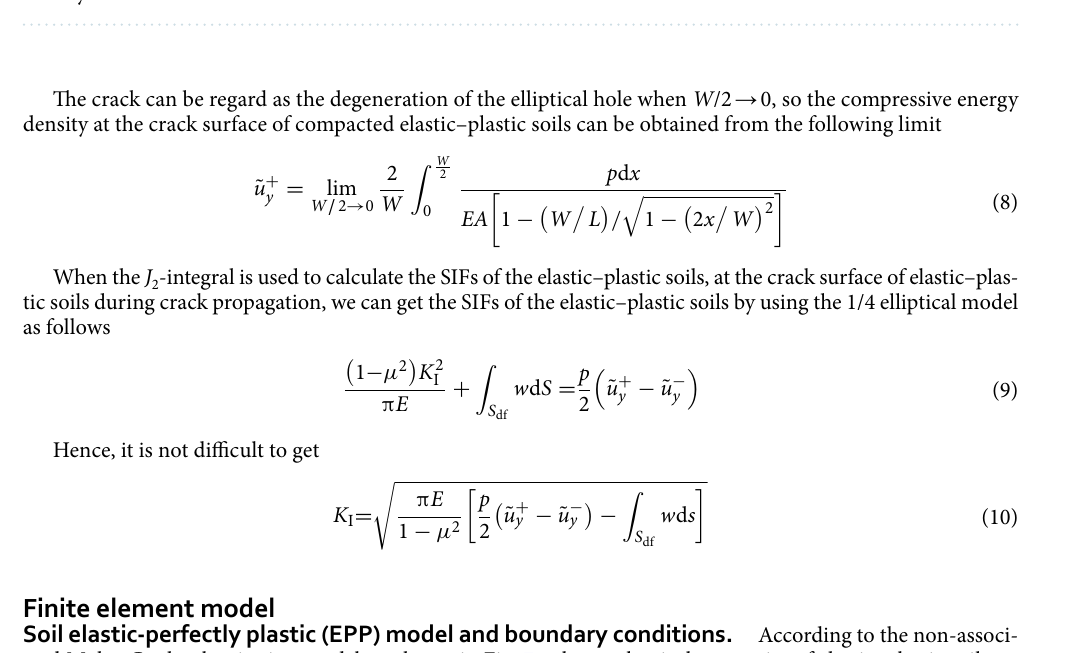
Figure 6. Compression curves of undisturbed and compacted remolded elastic–plastic soils with the same dry density.